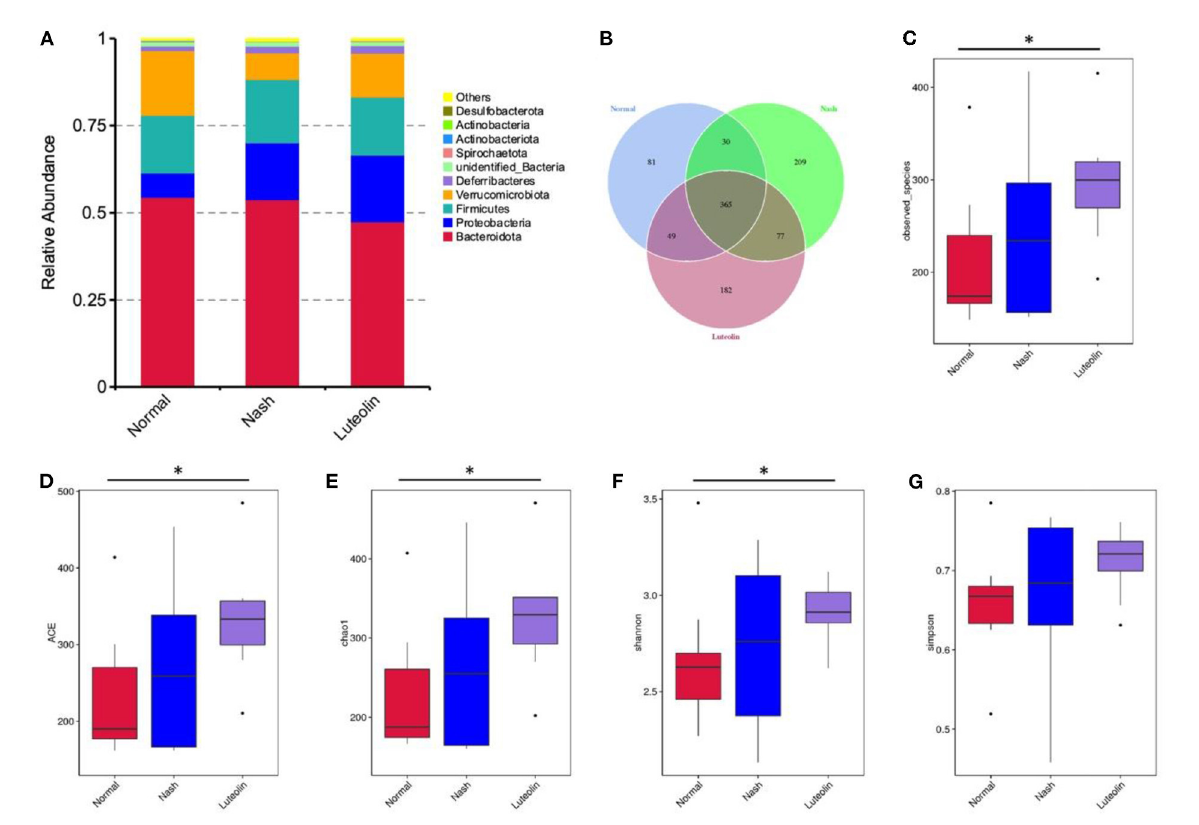
FIGURE5 Changes in gut microbiome composition among different groups. (A) Histogram of relative abundance of species at the phylum level; (B) Venn diagram; (C) boxplot of observed species; (D) boxplot of ACE index; (E) boxplot of Chao1 index; (F) boxplot of Shannon index; (G) boxplot of Simpson index. ( * p < 0.05, n = 6–8 per